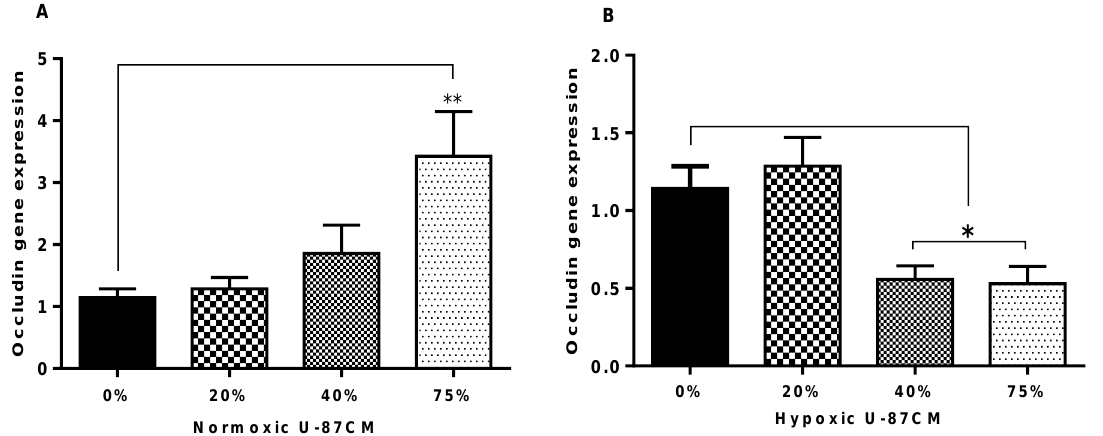
Figure 10. Gene expression level for Occludin in bEnd.3 cells after the exposure to selected concen- trations of U-87CM. ( A ) Shows Occludin gene expression in bEnd.3 cells that were exposed daily to U-87CM produced in normoxic conditions (21% O 2 ) (** p = 0.0047). ( B ) Represents gene expression of Occludin in bEnd.3 exposed daily to U-87CM produced under hypoxic conditions (5%O 2 ) (* p < 0.05), ( n = 4).